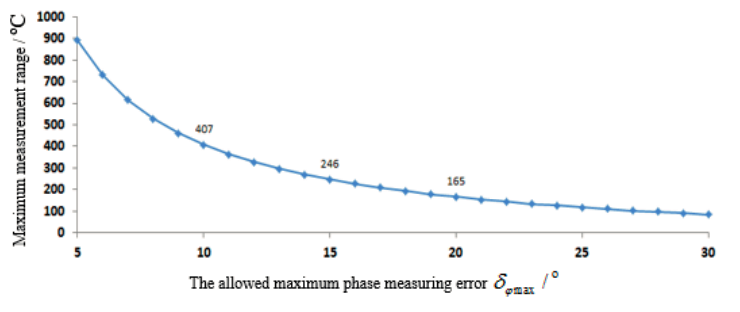
Figure 4. The relation curve between the maximum measurement range and the allowed maximum phase measuring error.